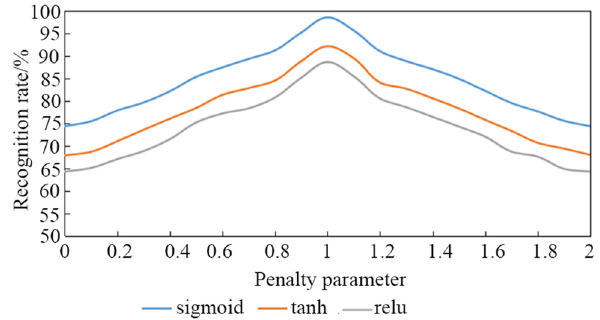
Figure 3: The cross - validation test results of the category of the kernel function and penalty